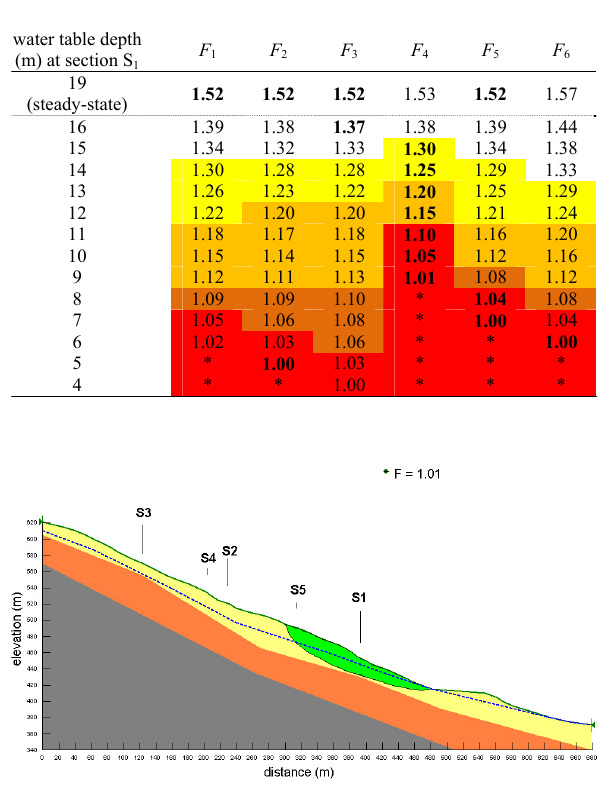
Fig. 12. San Rocco landslide: assumed water table geometry for depth of 9m at section S 1 . For the landslide body #4, it is F 4 =1.01.